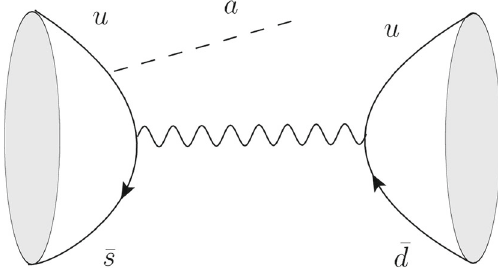
Fig. 1 Tree level contributions to the K + → π + a amplitude, with the ALP emitted from the K + meson. Diagrams where the ALP is emitted from the π + quarks are